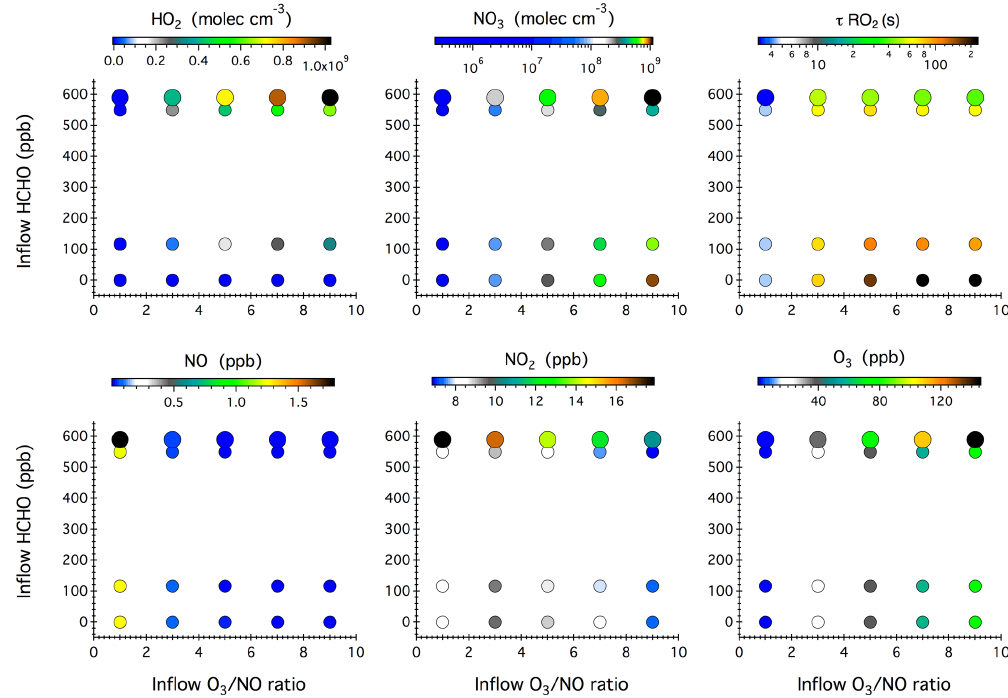
Figure 4. Simulated steady-state mixing ratios of HO 2 , NO 3 , NO, NO 2 , and O 3 after 16h of dark reactions in the chamber as a function of the concentrations of HCHO, NO, and O 3 in the continuous injection flow. The symbol size denotes different inflow NO concentrations, i.e., 10 and 20ppb. Also given here is the calculated lifetime of an RO 2 radical ( τ RO ) with respect to reactions with NO, NO 3 , and HO 2 2